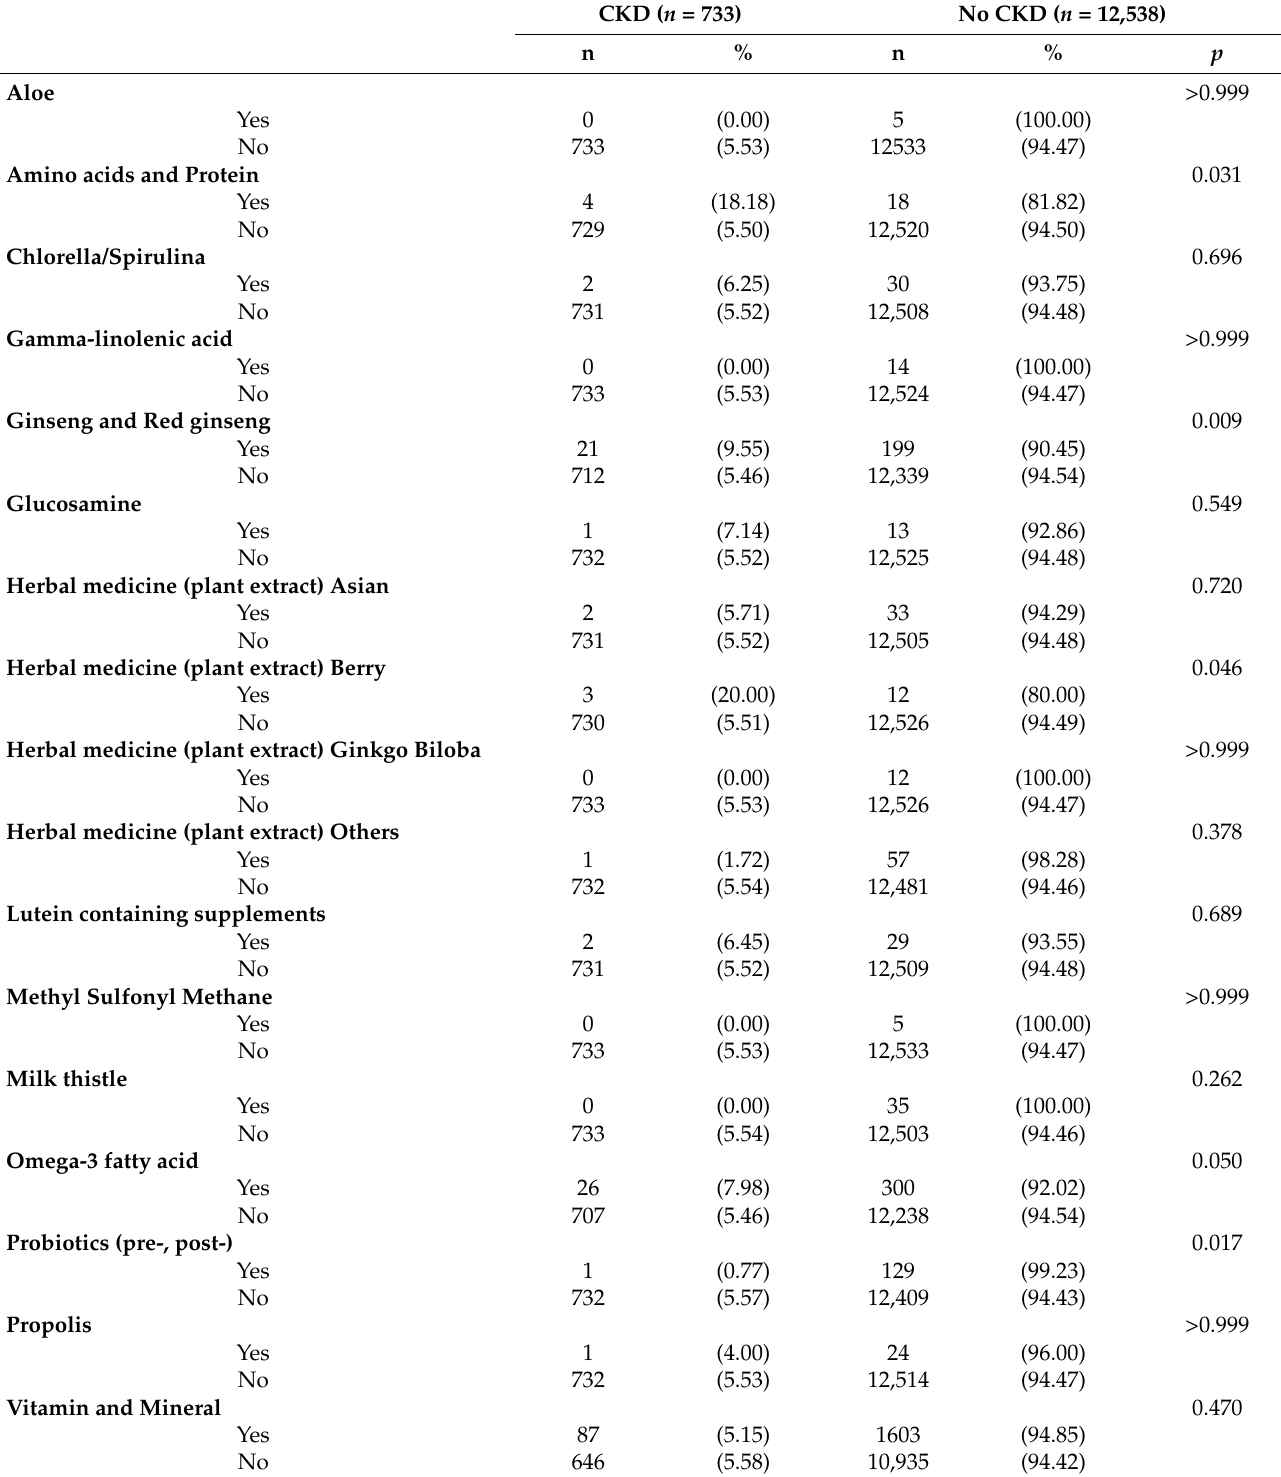
Table 2. Dietary supplements statuses of the participants ( n =